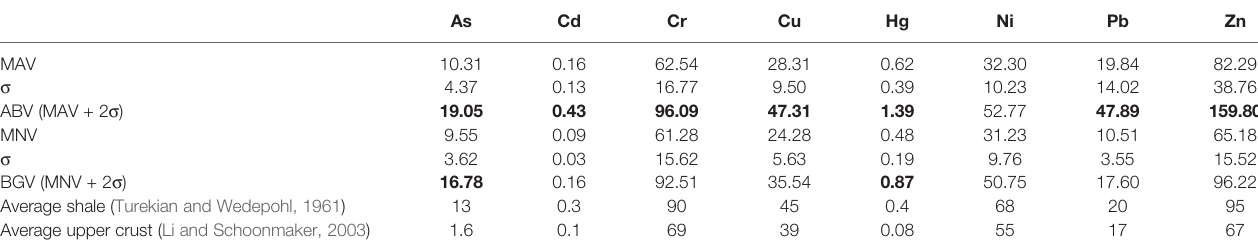
TABLE 1 | Orbetello Lagoon: MTEs parameters determined from the dataset including both natural and anthropogenically in fl uenced data (Mean Anthropogenically- in fl uenced Value - MAV; Anthropogenically-in fl uenced Background Value - ABV), are compared with those determined on the exclusively natural concentration data of the same dataset (Mean Natural Value – MNV; local Background Value - BGV) reported by Romano et al. (2015). As Cd Cr Cu Hg Ni Pb